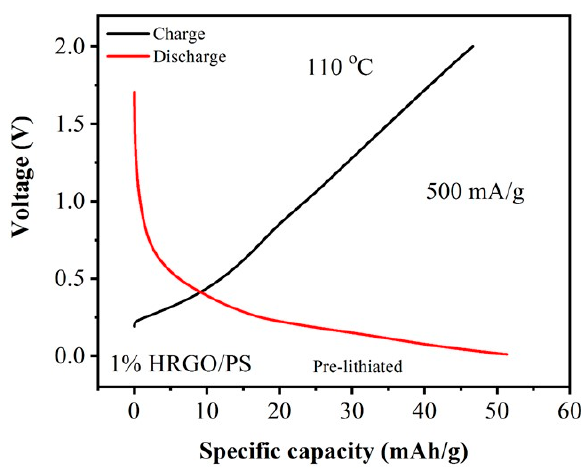
Figure 10. Galvanostatic charge/discharge curves for 1% HRGO/PS nanocomposites obtained at a current density of 500 mA/g at 110 °C.